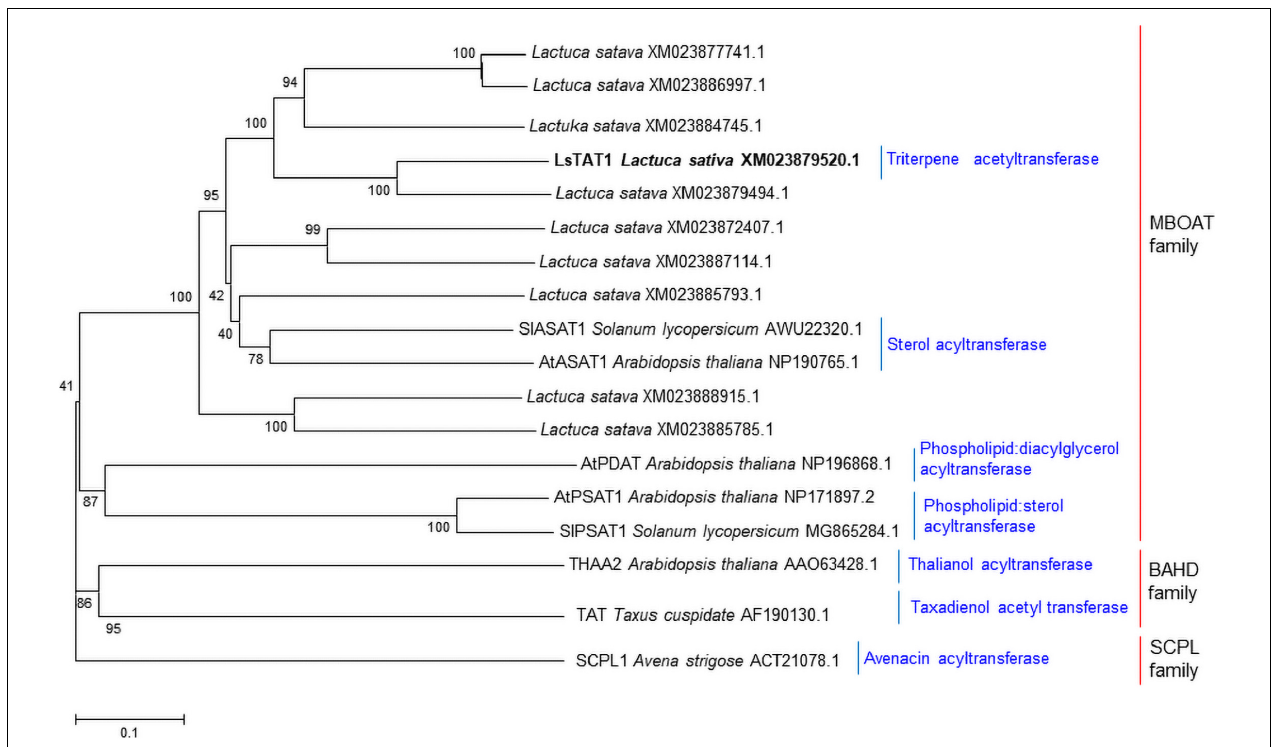
FIGURE 3 | Phylogenetic trees of the 10 putative sterol O -acyltransferases isolated from lettuce and other functionally characterized acyltransferases in plants. Phylogenetic trees of plant acyltransferase showing the distances between each clone and group were constructed using the program ClustalW. The distance between each clone was calculated by the neighbor-joining method with a bootstrap of 1,000 replications using Mega 5 software. The number at each node is the bootstrap value in